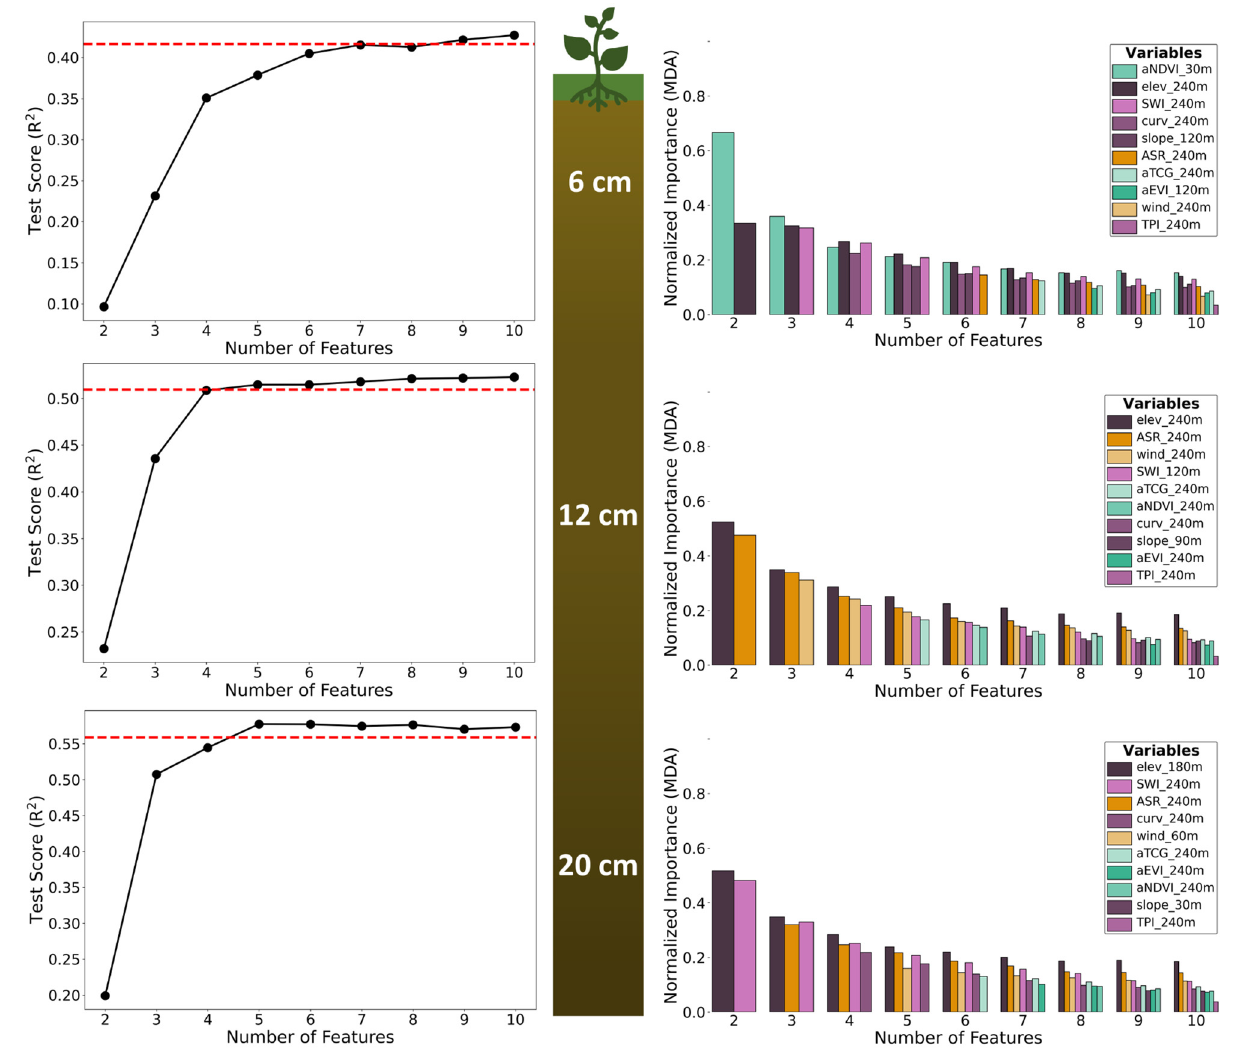
Figure 7. Results of a recursive feature elimination based on feature scales identified in the all-feature model. In the left-hand plots, we show an increase in the R 2 of the test scores as the number of features increases. The dashed red line indicates a threshold of 2.5% used to identify the number of features used in the final model for each depth. The right-hand side plots show the permutation feature importance (MDA) for the features included in each model fitting stage. We show plots for 6 cm, 12 cm, and 20 cm soil depths.